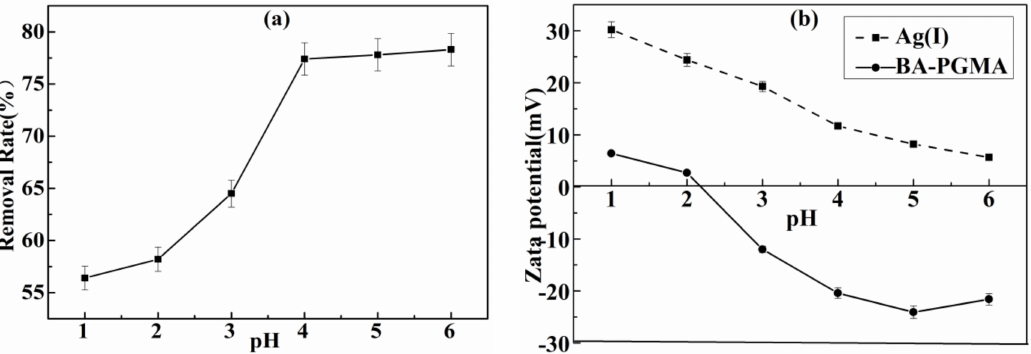
Figure 4. Effect of pH on the removal rate of Ag(I) ( a ) and zeta potential of BA-PGMA ( b